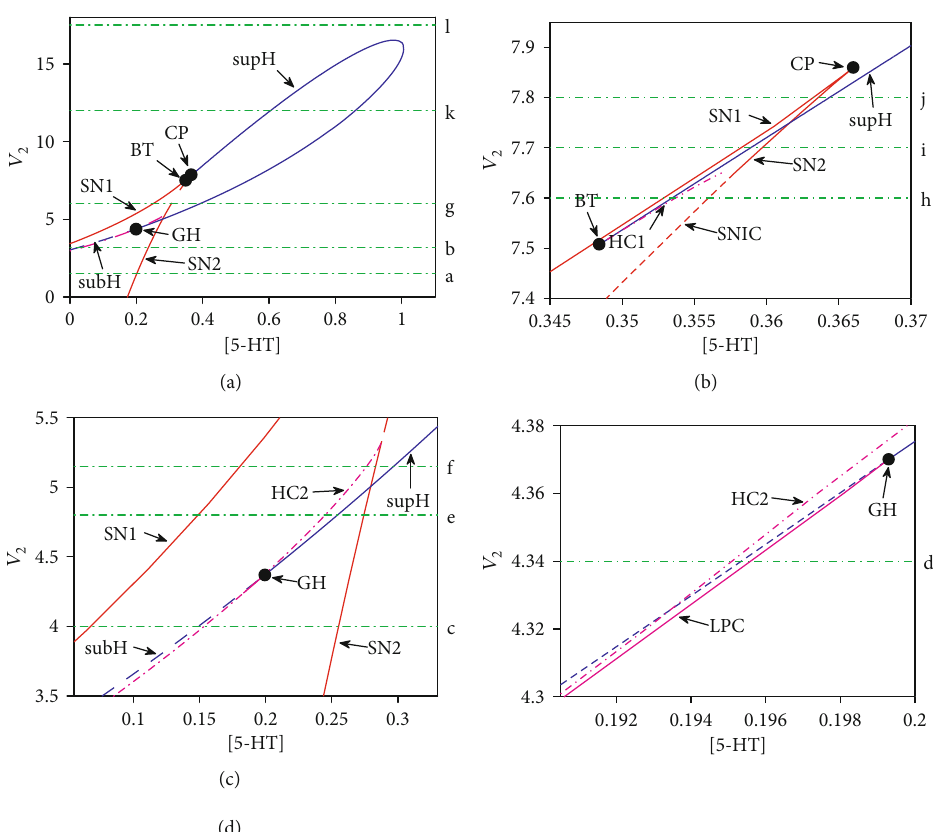
Þ parameter plane. The red solid line, red dashed line, blue solid line, blue dashed line, Figure 2: Bifurcation diagram in the ð½ 5 ‐ HT (cid:2) , V 2 magenta solid line, and magenta dash-dotted line depict the saddle-node bifurcation points (SN), saddle-node invariant circle bifurcation points (SNIC), supercritical Hopf bifurcation points (supH), subcritical Hopf bifurcation points (subH), fold limit cycle bifurcation points (LPC), and homoclinic bifurcation points (HC)), respectively. Three codimension-2 bifurcation points exist: a cusp point (CP), a Bogdanov-Takens bifurcation point (BT), and a generalized Hopf bifurcation point (GH). (b – d) are the enlargement of